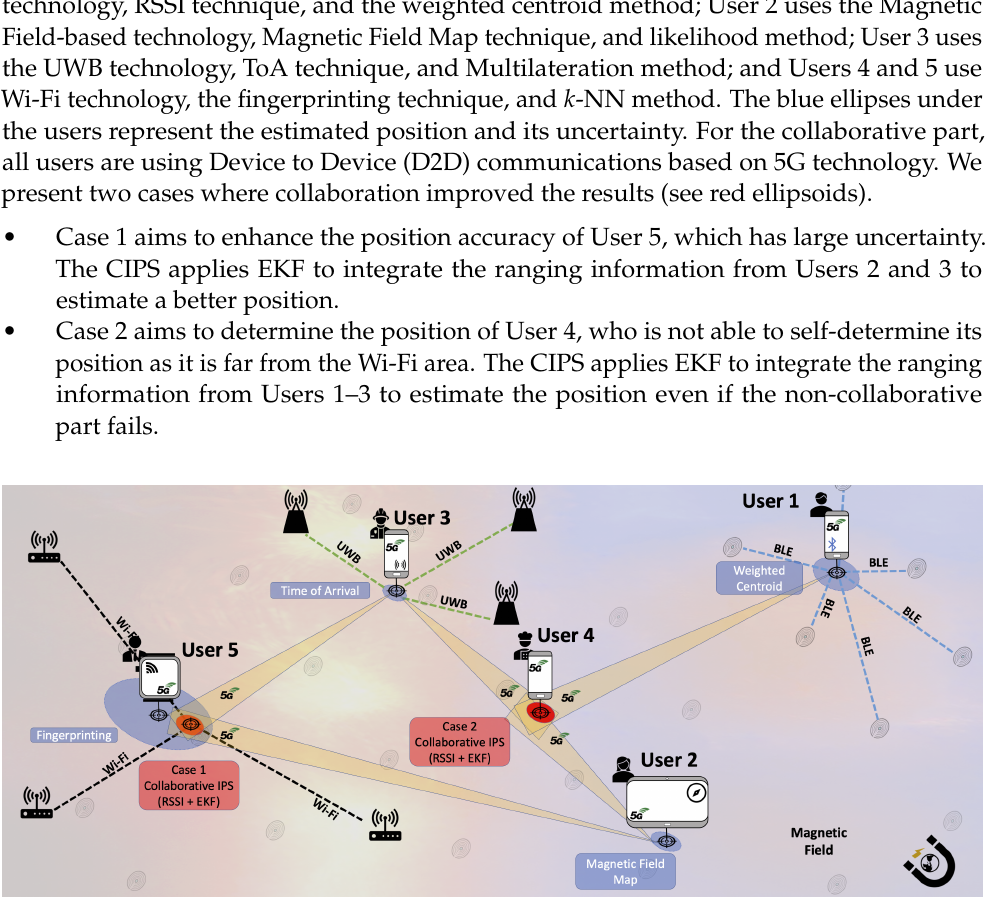
Figure 1. Representative example of a heterogeneous collaborative indoor positioning system. Source: